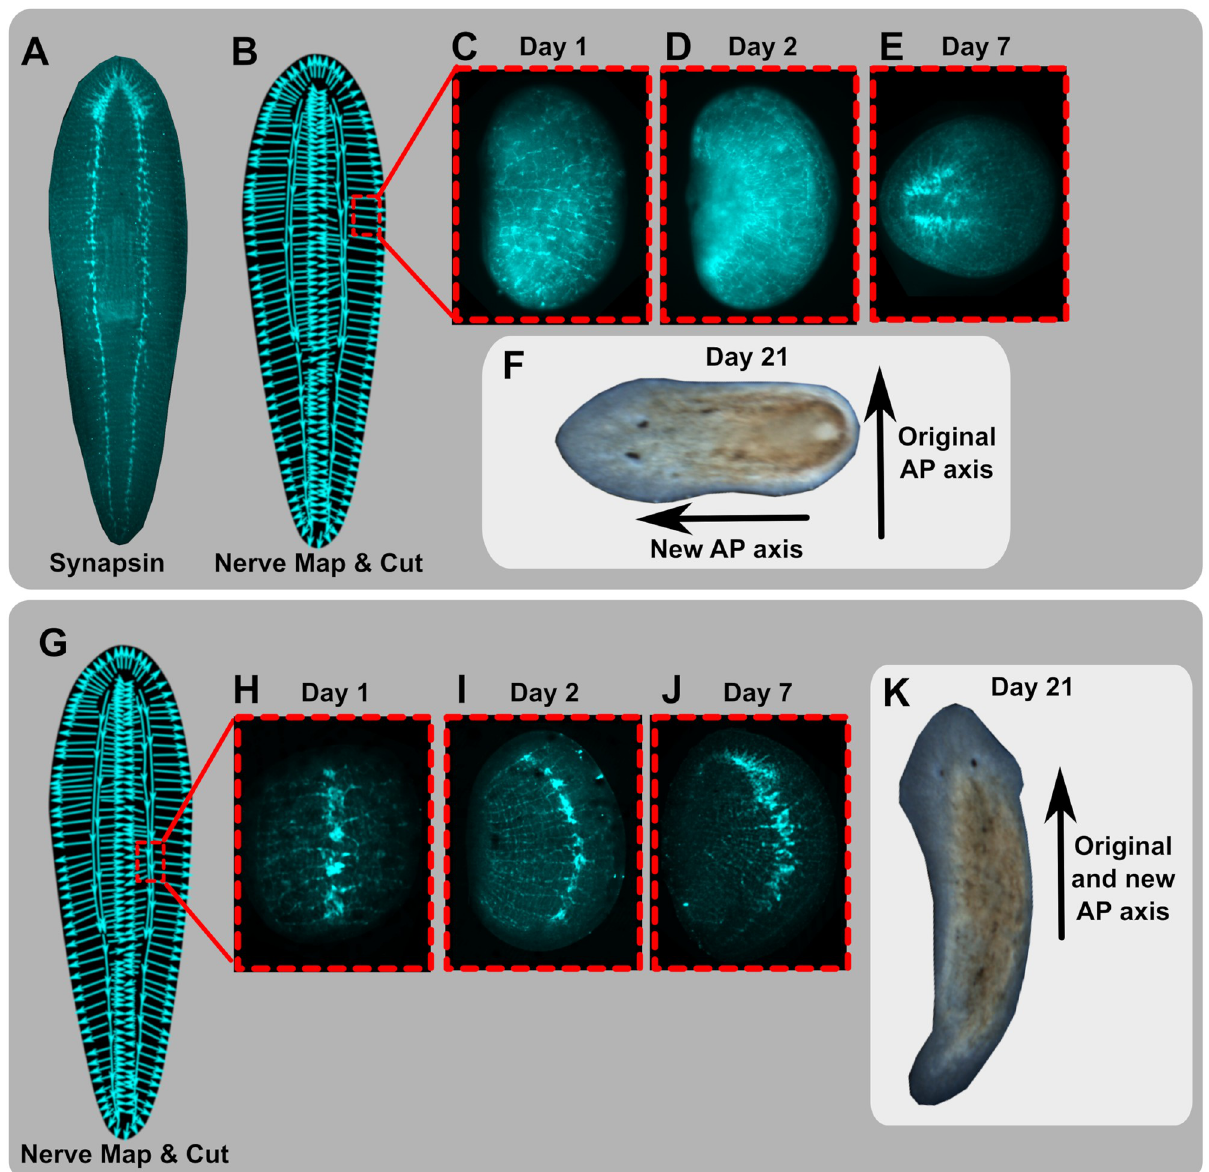
Fig 6. The net nerve alignment in a fragment determines regenerated anterior-posterior axis, where fragments with initial axon orientation perpendicular to the original axis show 90˚ rotation of the regenerated anterior-posterior axis. Synapsin stains of whole 1H worms (A) and hypothesized nerve polarity map traces with location of rectangular fragment cut regions are shown (B, G). The aspect ratio of all fragments was cut such that the longest side of the rectangular fragment corresponded with the original anterior-posterior axis. Rectangular fragments cut from the side margin of worms (B, with time-course of synapsin stains of fragments shown in C, D, and E) regenerated with anterior-posterior axis oriented perpendicular to the original axis (F), consistent with the fragment’s proposed net nerve polarity (B and C), an outcome which was observed in N = 94/ 94 replicates. In contrast, fragments of the same size and shape cut to include a portion of the ventral nerve cord (G, with time-course shown in H, I and J) regenerated as 1H worms with new axis corresponding to that of the original worm (K), an outcome observed in N = 103/103